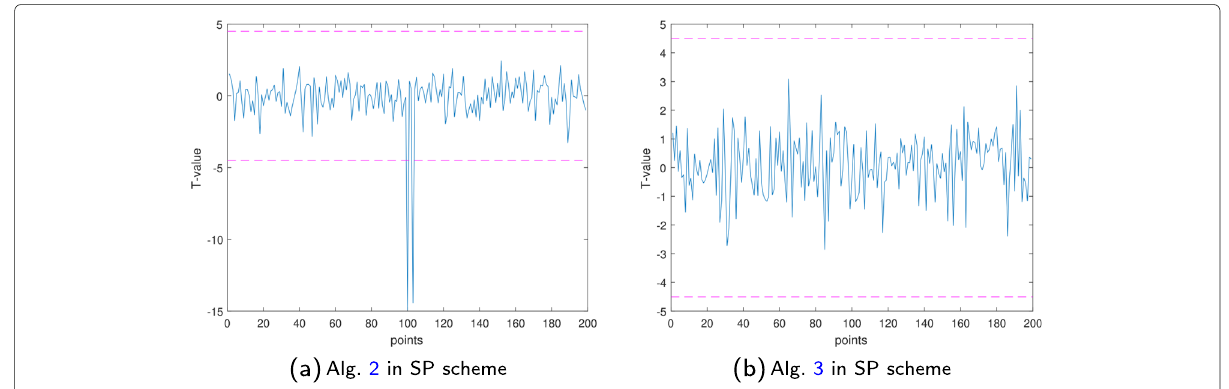
Fig. 4 T-test on simulated leakages of Algorithm 2 and Algorithm 3 in SP scheme